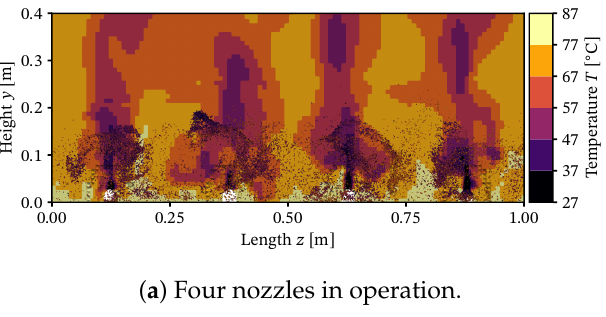
µ 0 ( t evap ) , is the highest for one nozzle, followed by two and four nozzles, respectively.